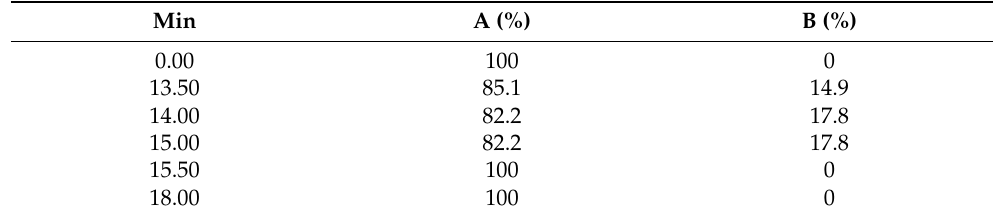
Table 1. Gradient for HPLC–DAD analysis for the quantification of thiopurine metabolites in RBCs